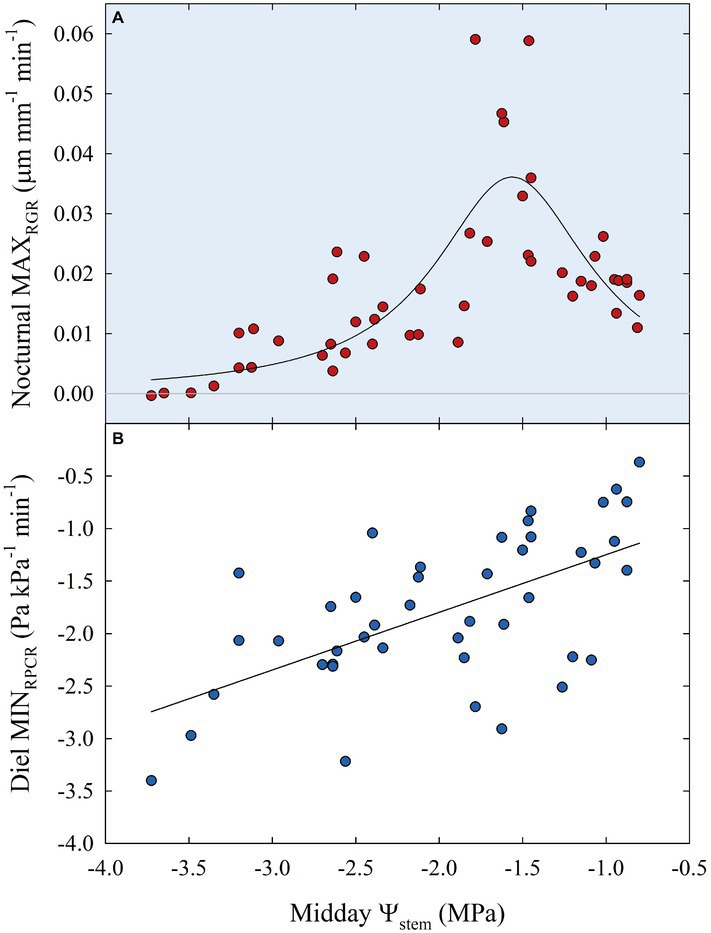
Maximum nocturnal fruit relative growth rate (MAXRGR) vs. midday Ψstem
(A) and minimum diel leaf relative pressure change rate (MINRPCR) vs. midday Ψstem
(B) for all fruit growth stages and irrigation treatments. Nonlinear regression in panel (A): MAXRGR = 0.04/{1 + [(Ψstem + 1.56)/0.57]2}, R2 = 0.597, p < 0.001. Linear regression in panel (B): MINRPCR = −0.70 + 0.55 × Ψstem, R2 = 0.369, p < 0.001.